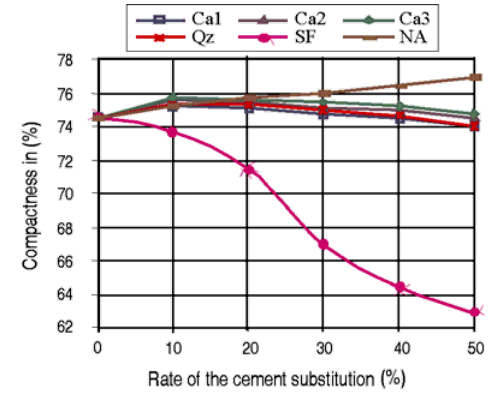
Fig 2. Effect of the cement substitution by mineral admix- tures on the compactness of mortars